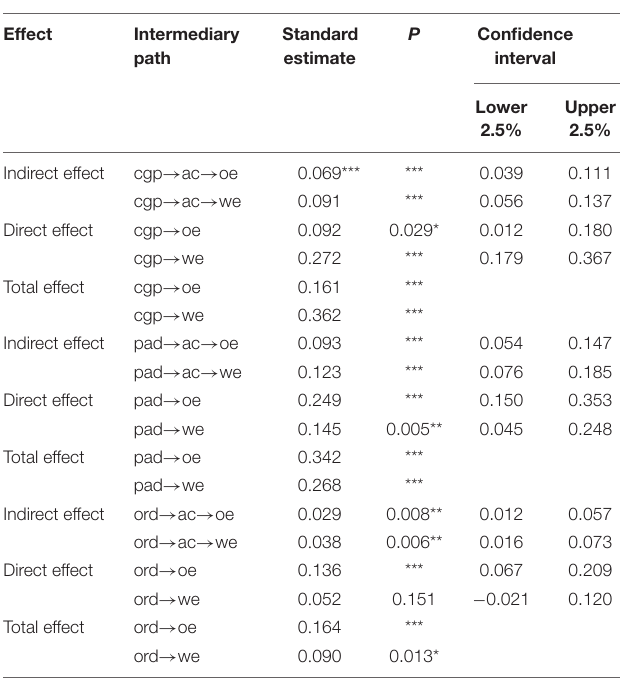
TABLE 3 | Mediating effect test.